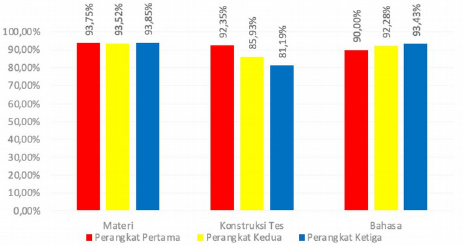
Figure 10. Graph of Educational Practitioners Theoretical